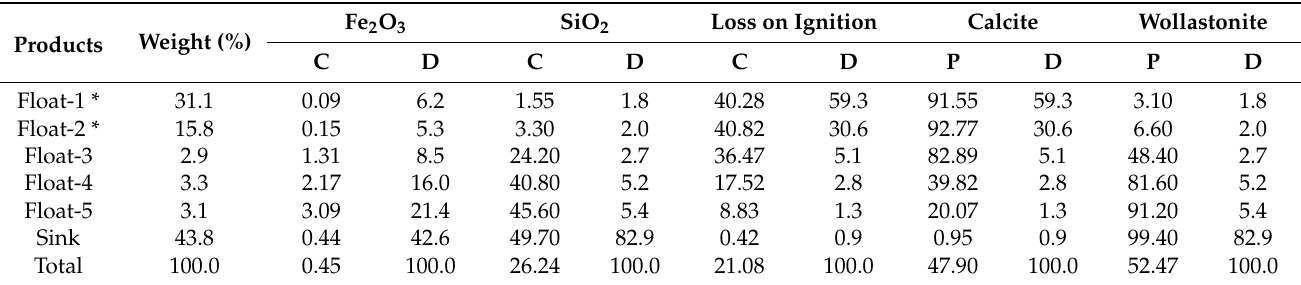
Table 3. Results of flotation tests.